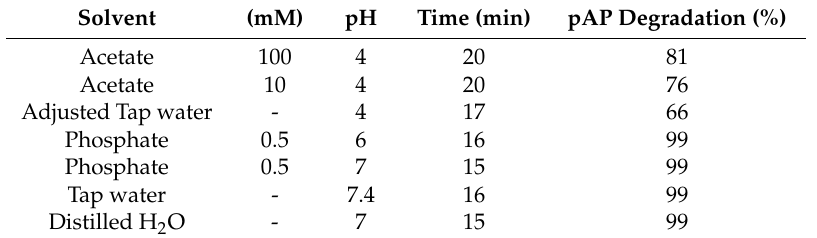
Table 1. pAP degradation at different conditions catalyzed by FeCO 3 NRs@CALB ‐ Mentha a .